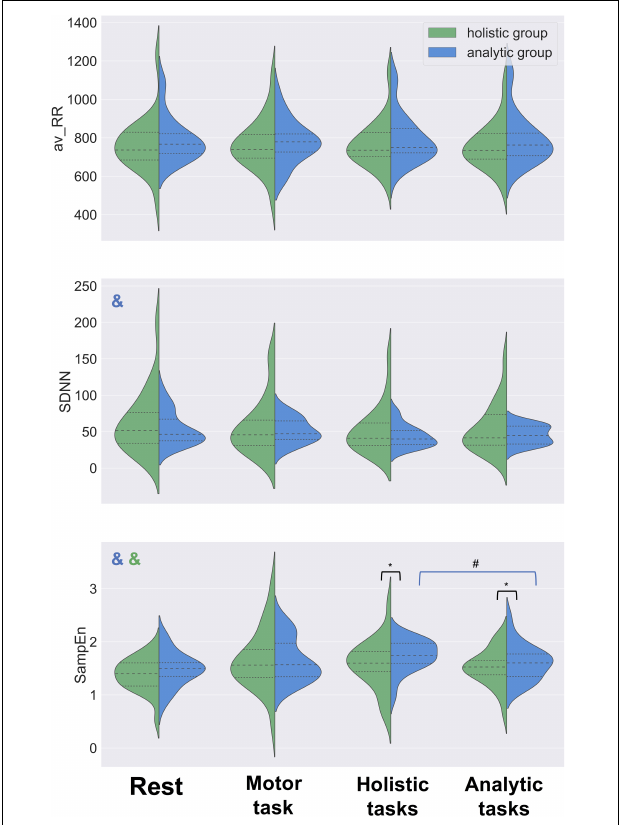
FIGURE 3 | HRV dynamics in analytic and holistic groups. Distribution shapes, median values (dashed lines) and quartiles (dotted lines) are shown for av-RR, SDNN and SampEn estimates. No significant difference between the groups was found in av-RR or SDNN values for baseline, motor task or either type of the cognitive tasks. Higher values of SampEn were observed in the analytic group, as compared with the holistic group, in both analytic and holistic types of tasks. No difference in SampEn was observed between analytic and holistic groups in the baseline or during the motor task. SampEn was increasing from the rest (baseline) condition to the experimental tasks in both groups. SDNN was decreasing from the rest (baseline) condition to the experimental tasks in the analytic group of participants, and their SampEn was higher during solving holistic tasks, as compared to analytic tasks. Mann-Whitney U test, * p < 0.05; Wilcoxon test, # p < 0.05; Friedman test, & p < 0.05 (color of & reflects the group of